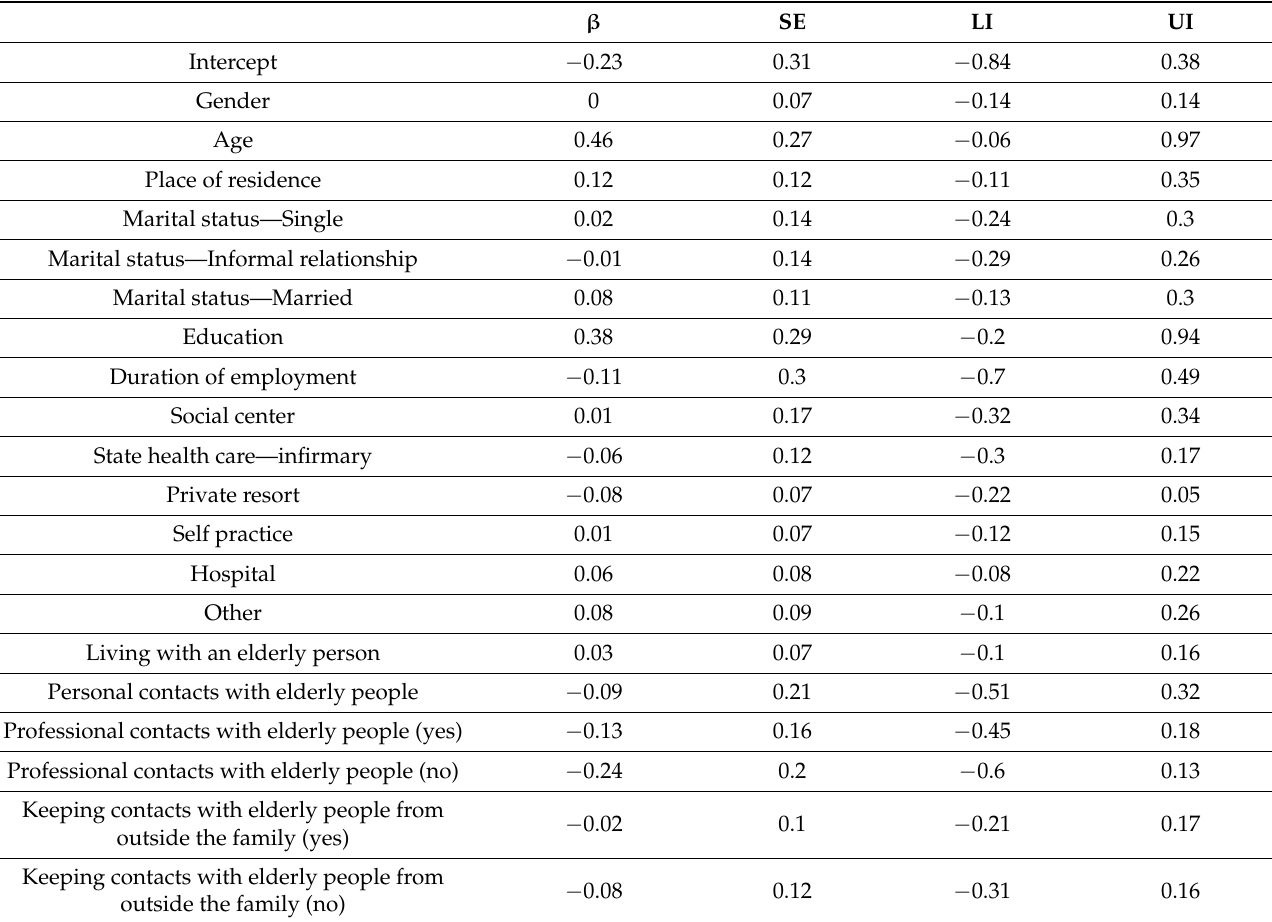
Table 2. Results of Bayesian robust linear regression with KOAP score as the dependent variable. β